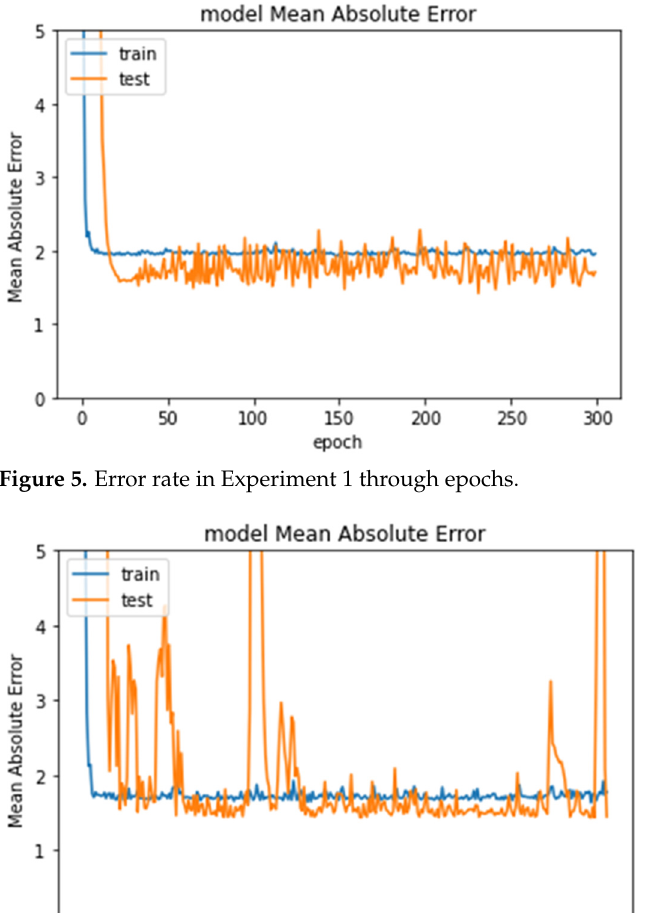
Figure 6. Error rate for Experiment 2 through epochs.